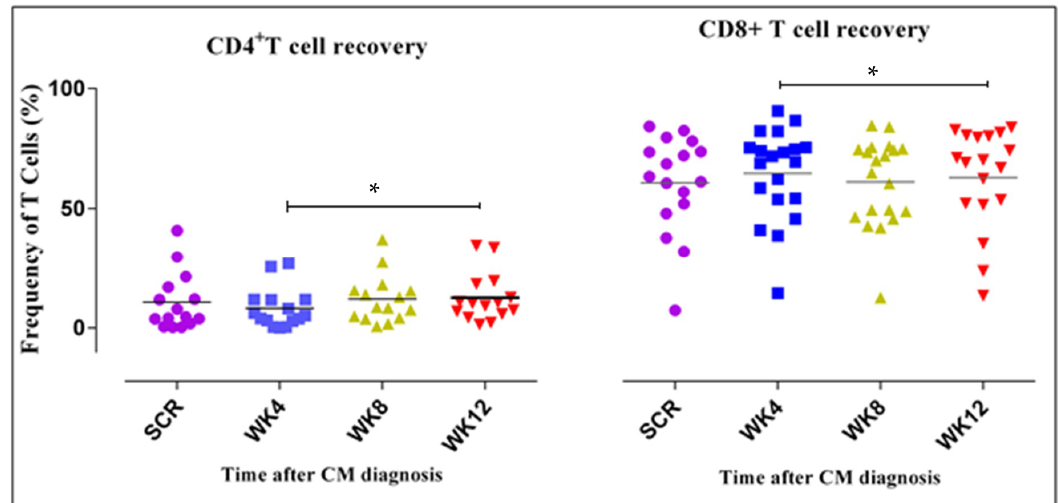
Figure 2. Recovery of CD4 + and CD8 + T cell populations.